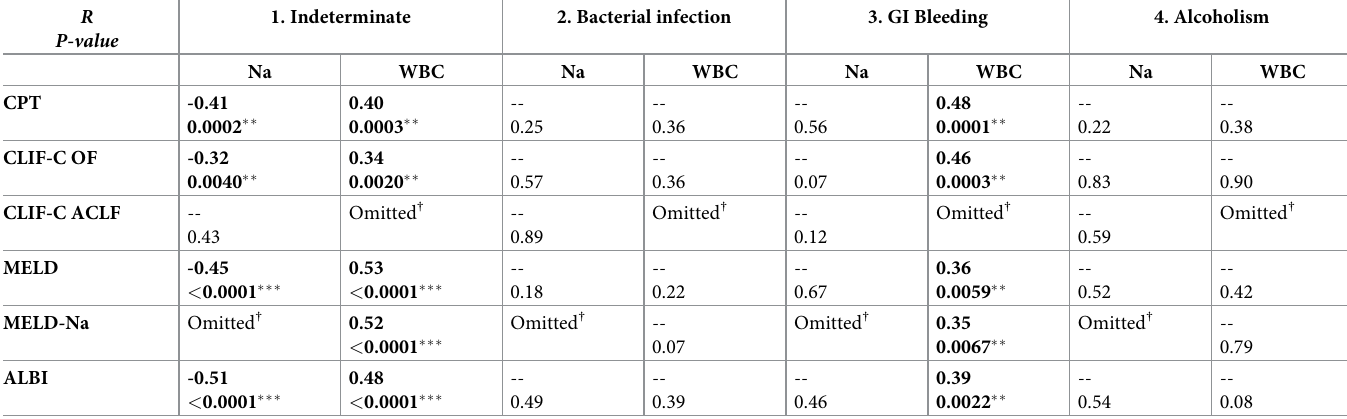
Table 3. Statistics of Spearman’s correlation between serum sodium/white blood cell count and prognostic